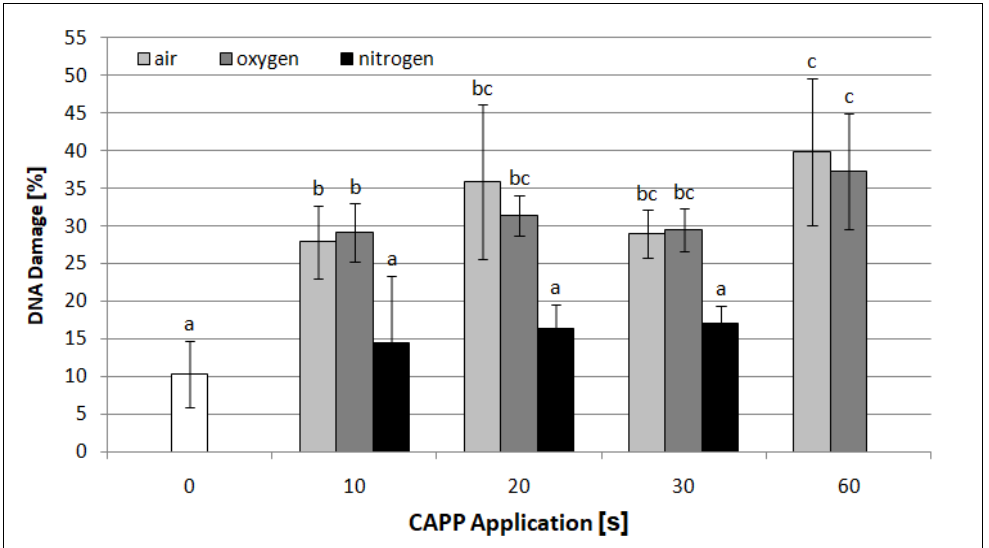
Figure 7. Graphical representation of the DNA damage effect of CAPP generated in ambient air, oxygen and nitrogen at exposure times of 10–60 s in barley leaves, analyzed by comet assay modified with formamidopyrimidine DNA glycosylase (Fpg). At least 200 nuclei were analyzed per slide. The data were analyzed using the statistical method LSD ANOVA and comparisons between the mean values were considered significant at p ≤ 0.05. Bars are means of three experimental runs ± SD.